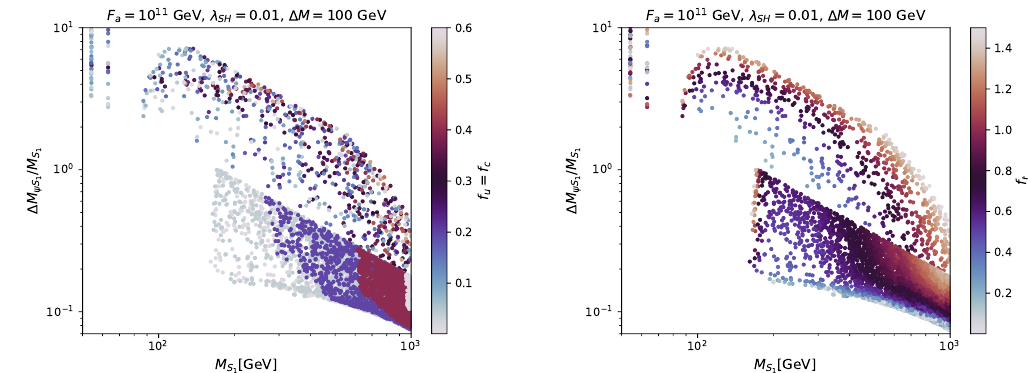
Figure 4. Parameter space satisfying observed DM abundance and also allowed by the direct search experiments in the bi-dimensional plane of ∆ M Ψ S 1 with respect to: Left Panel: the Yukawa couplings f f t . In both the plots we fix F a = 10 11 GeV , λ SH = 0 . 01 , ∆ M = 100 GeV while we vary f t in the range 0–1.5 and f = f in the range u c